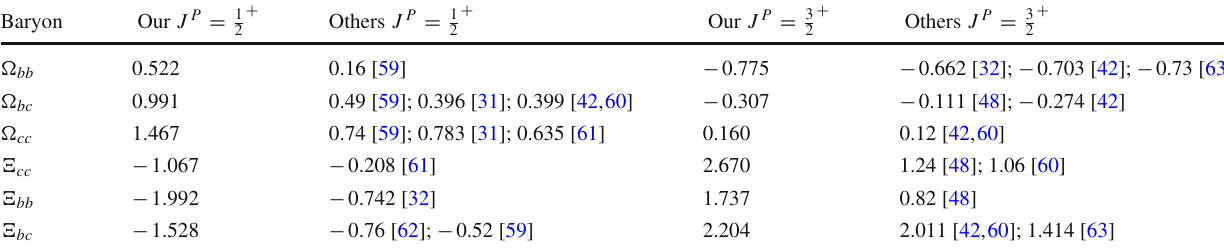
Table 3 Magnetic moments of double heavy baryons (in μ N